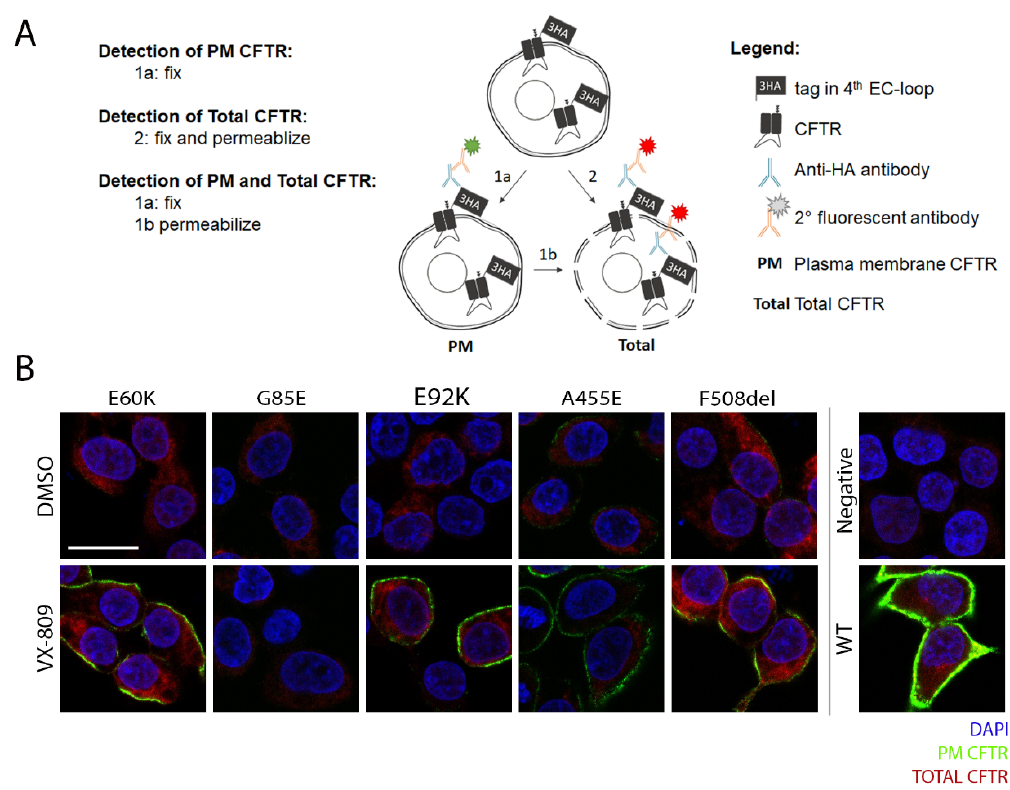
Figure 4. Mutant CFTR expression and subcellular localization. ( A ) Schematic overview of the staining procedure for detection of PM localized and / or total CFTR by its 3HA-tag. ( B ) Detection of PM localized (green) and total (red) 3HA-CFTR in stable HEK293T cell lines, visualized by sequential PM and total HA.11-antibody staining using confocal microscopy. Nuclei (blue) were stained with DAPI. Negative cells (VX-809 treated) and WT-CFTR (DMSO treated) are shown as a reference. Scale bar = 20 µ m. 3HA: triple hemagglutinin, EC: extracellular, PM: plasma membrane.